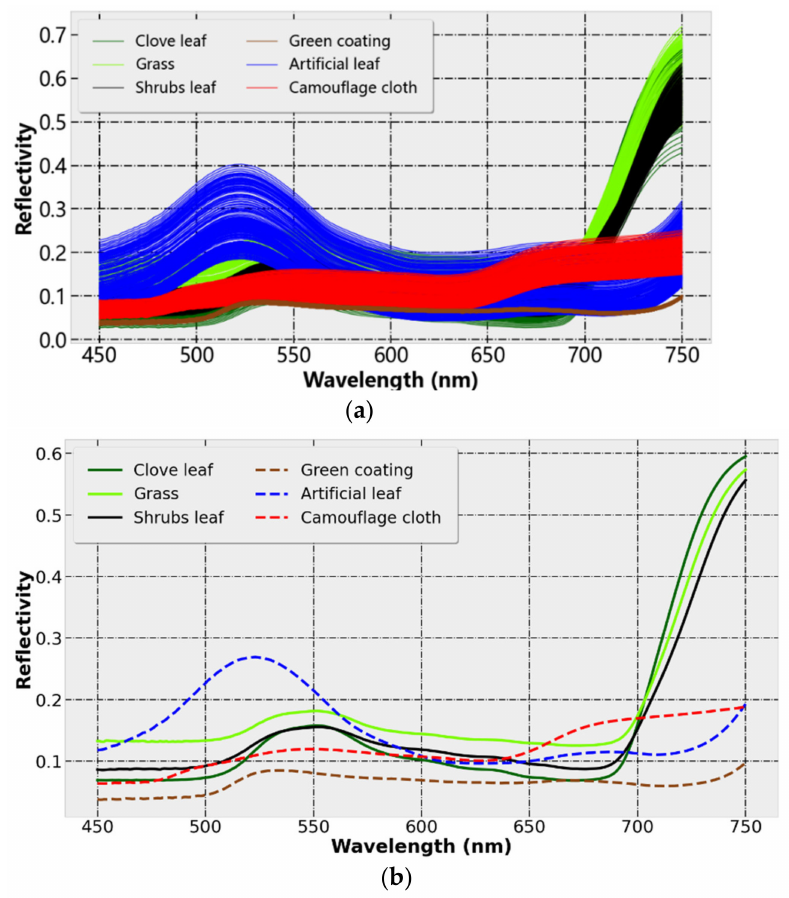
Figure 5. ( a ) Reflectance of all measurement points; ( b ) average reflectance of